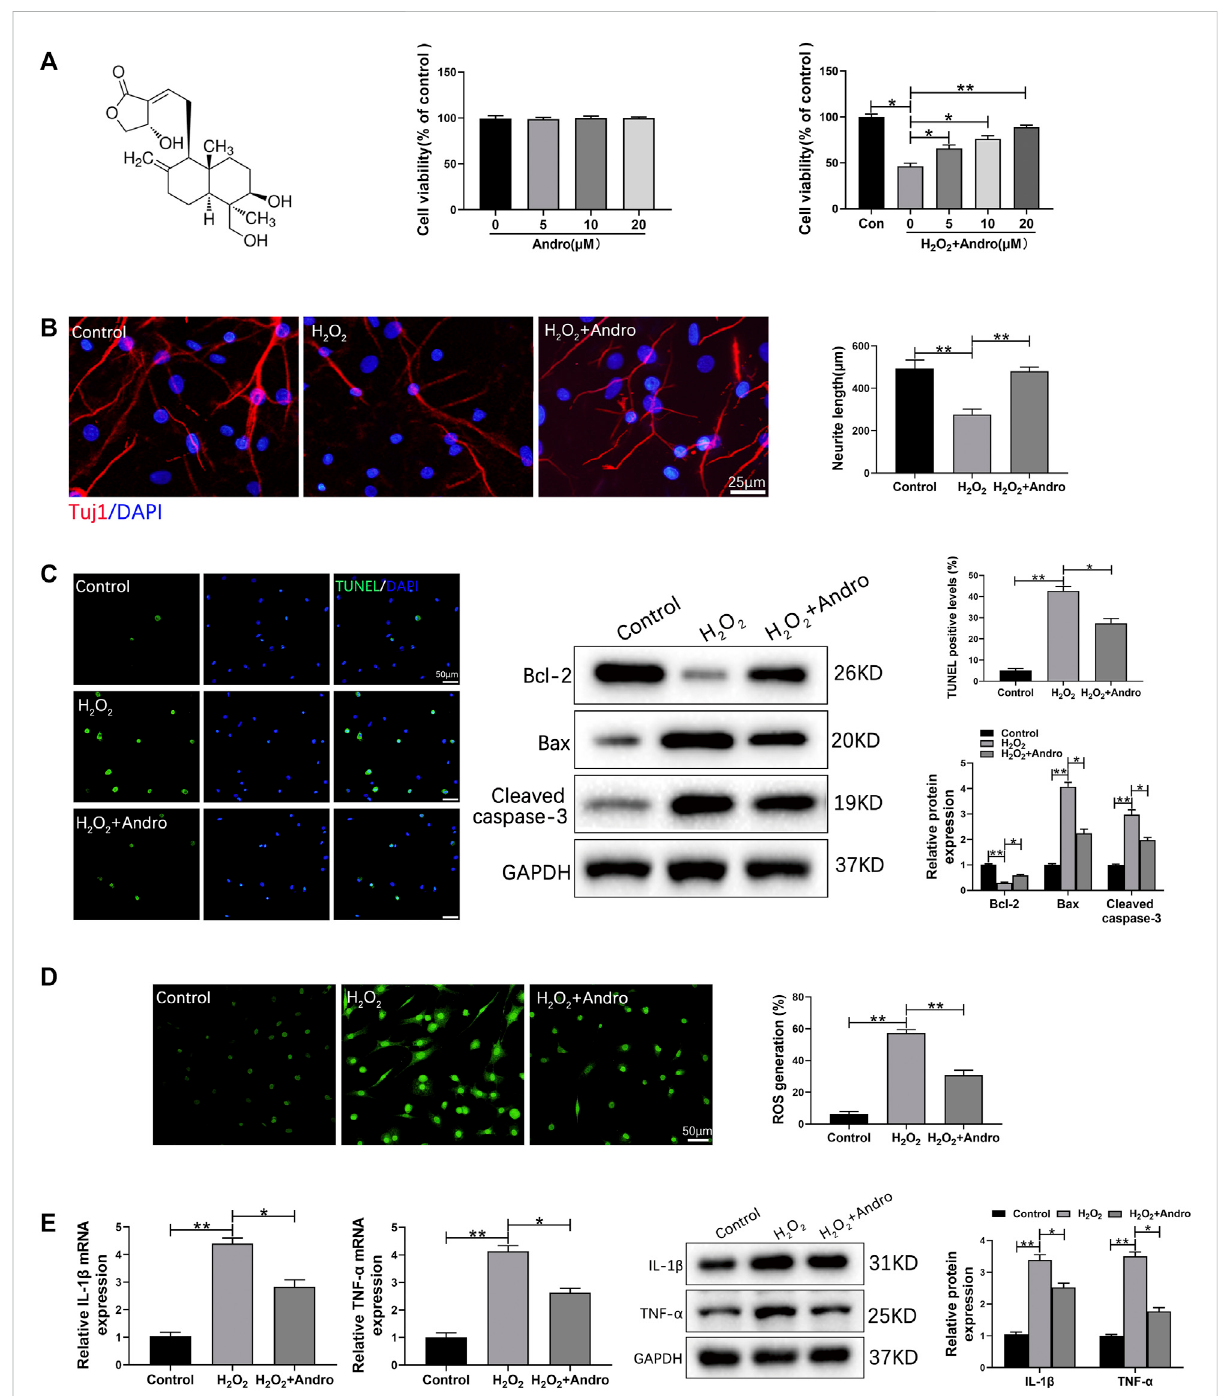
FIGURE 7 Andro treatment abrogated H 2 O 2 -induced apoptosis, oxidative stress and in fl ammation in cortical neurons. (A) The molecular structure of Andro and cell viability in response to different concentrations of Andro. (B) Immuno fl uorescence images showing the axon labeled with Tuj1 in primary cortical neurons and the mean neurite length ranges was counted and ploted. (C) TUNEL staining showing apoptotic cells and immunoblot showing the expression levels of Bcl-2, Bax and Cleaved caspase-3. (D) ROS production in cortical neurons was measured by DCF staining. (E) IL-1 β and TNF- α mRNA and protein levels in the indicated groups. Data are presented as the mean ± SD, n = 3 per group.* p < 0.05,** p < 0.01, ns p ＞